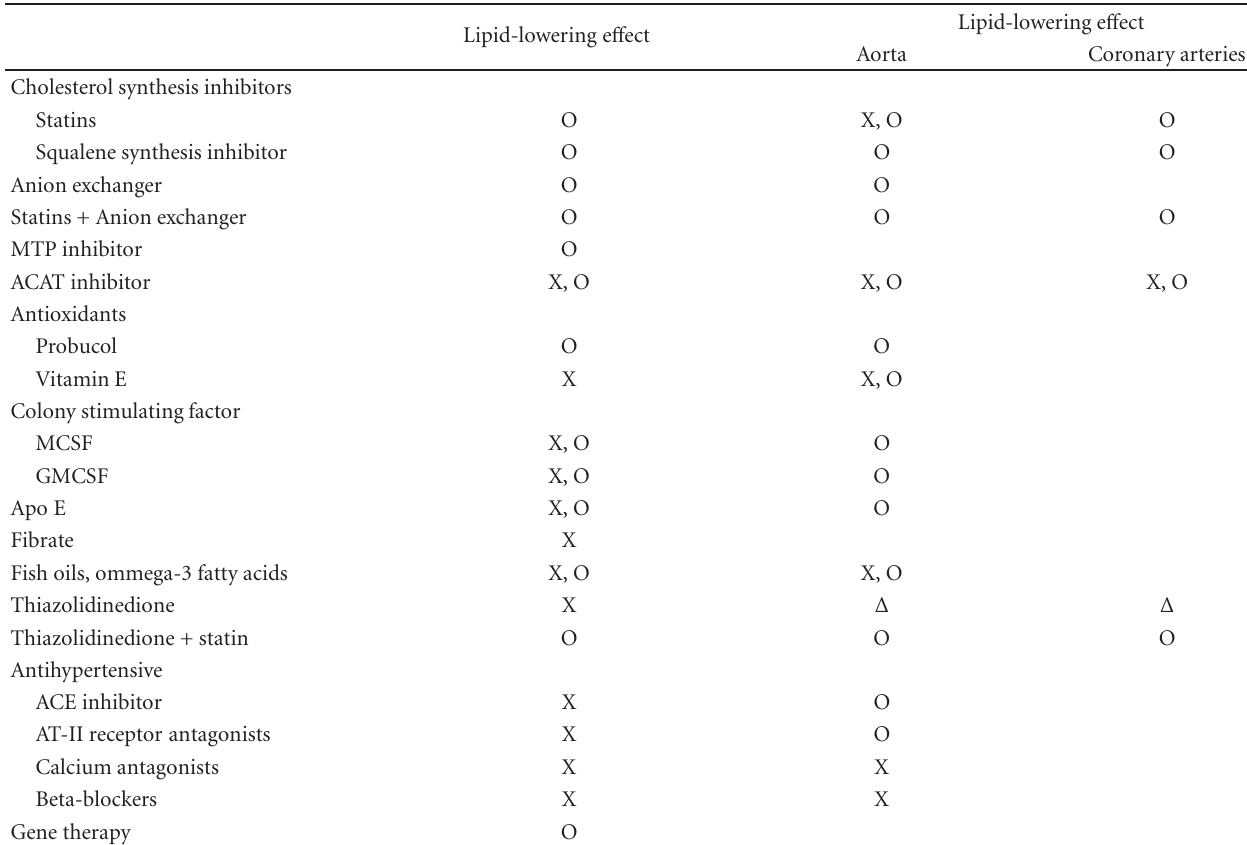
Table 2: Drug development using WHHL/WHHLMI rabbits.